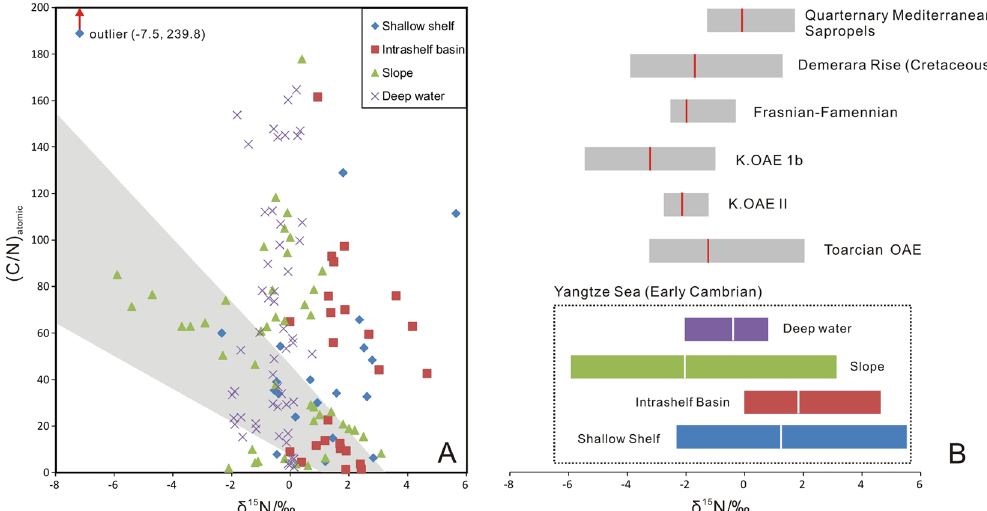
Figure 3. ( A ) Scatter plot of δ 15 N data and atomic C/N ratios from diverse depositional environments represented in various sections comprising Yangtze Sea deposits (refs 20, 21 and this study). The gray shade represents the range for those samples deposited during the OAEs 29 . ( B ) Comparisons of δ 15 N values recorded by marine sediments from the early-Cambrian Yangtze Sea and those from periods of widespread anoxia and OAEs (Data are sourced from refs 28 and 29). The gray box represents the range of values excluding outliers, with the line red/white in the box indicating mean